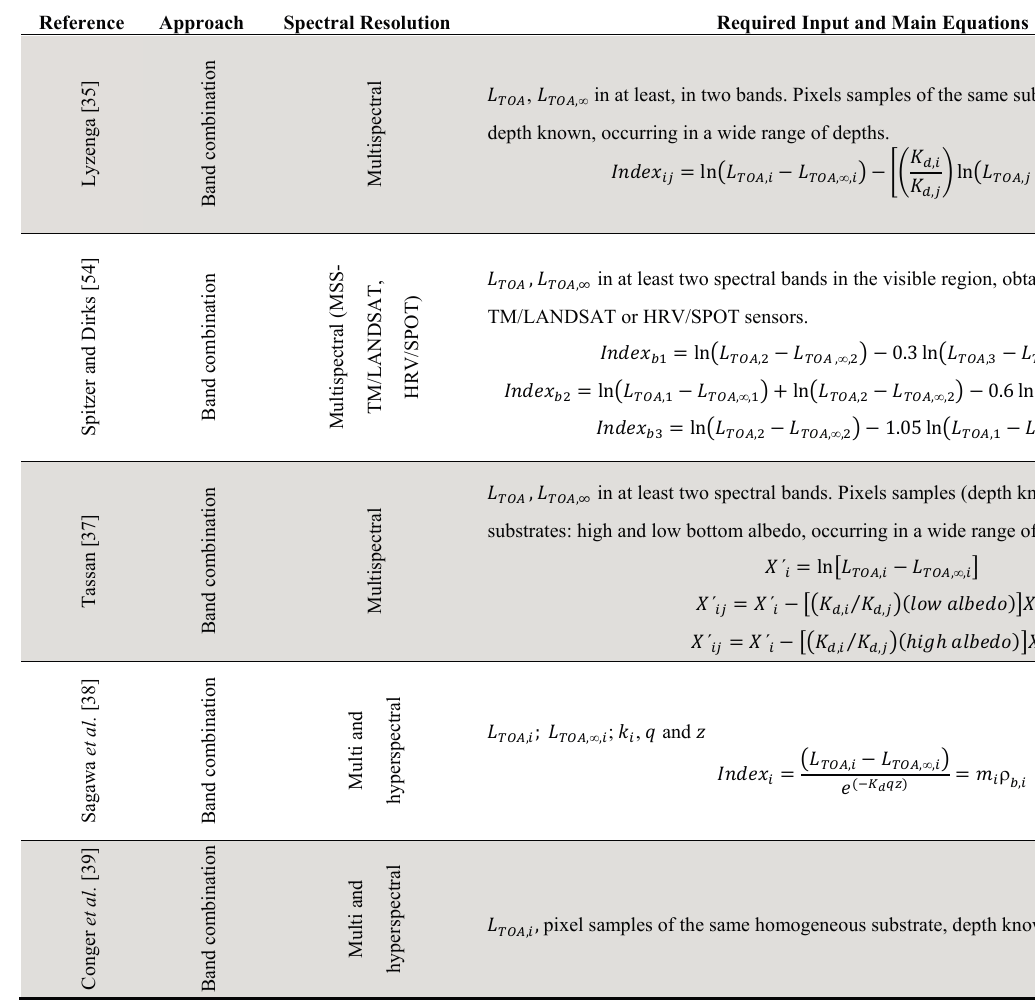
Table 1. Summary of models reviewed in this paper considering methodological approach, data spectral resolution, data required, model results and other